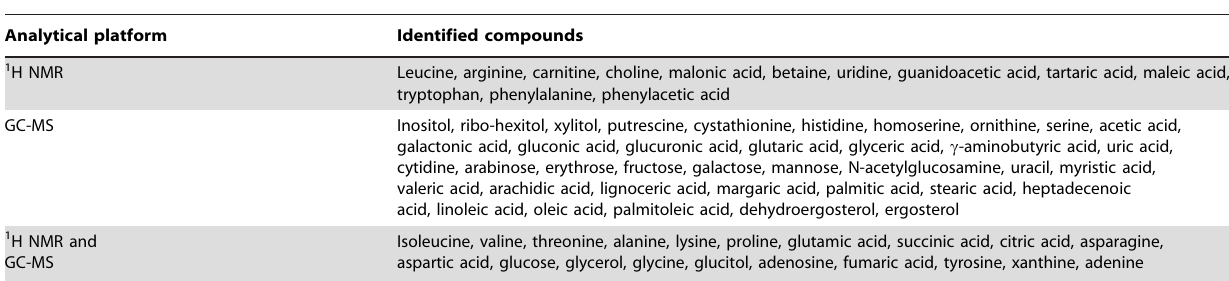
Table 5. The list of metabolites identified by 1 H NMR and GC-MS analysis.